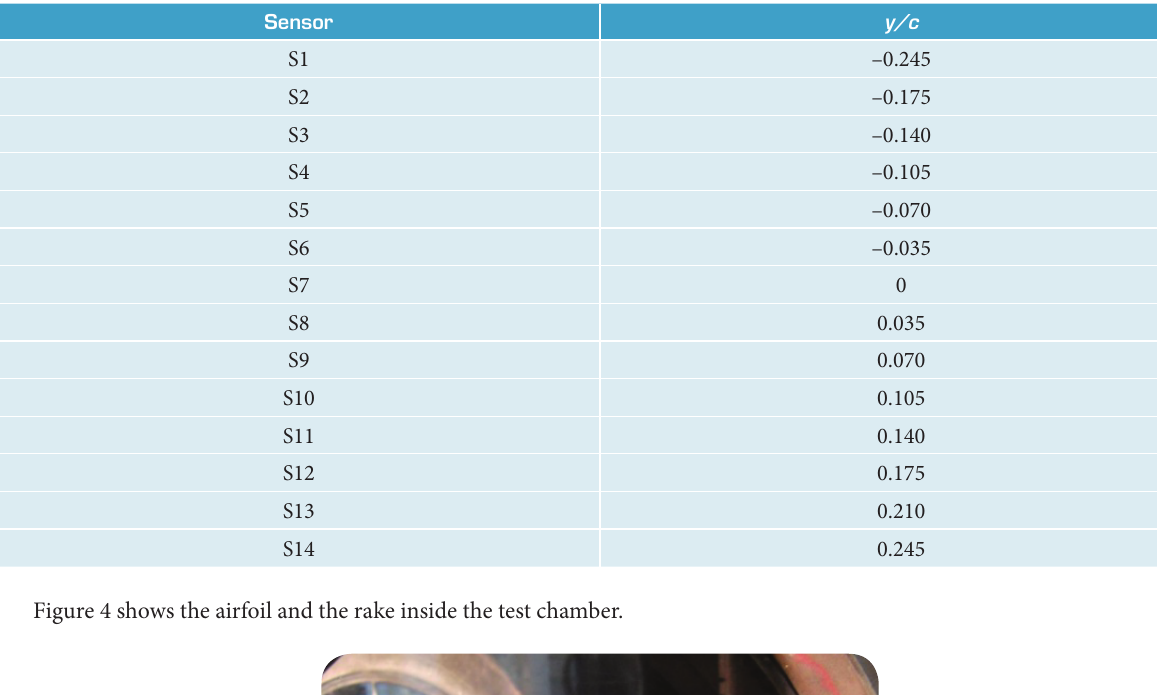
Table 1. Hot wire sensors location.